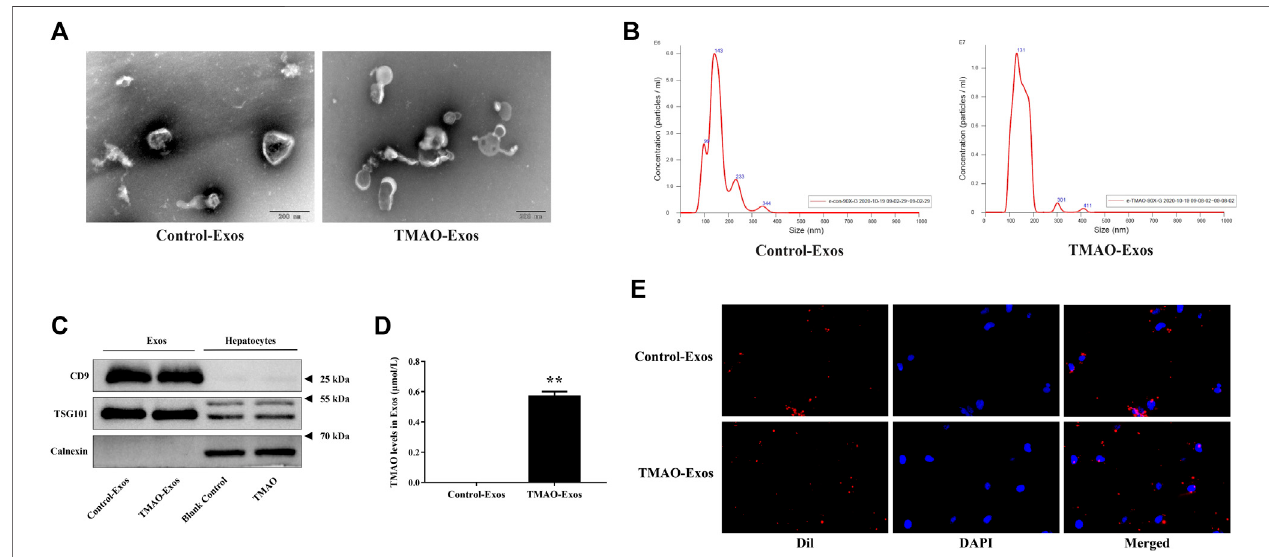
FIGURE 1 | Isolation and characterization of exosomes from hepatocyte culture supernatant. (A) Nanovesicles with diameters around 100 nm were isolated and puri fi ed from the AML12 cell culture supernatant, which possessed the characteristic size range of exosomes (Exos) under electron microscopes. Bar: 200 nm. (B) The size distribution of the Exos showed no signi fi cant difference between trimethylamine-N-oxide (TMAO)-free group (Control-Exos) and TMAO-Exos. (C) Exosomal markers of CD9 and TSG101 were enriched in Exos groups, and the negative markers of calnexin were detected only in whole cell lysate. (D) TMAO was undetectable in Control-Exos, but a small quantity of TMAO remained in TMAO-Exos. Data were expressed as mean ± standard error of the mean (SEM). n = 3, independent t -test wasperformed for comparisons; ** p < 0.01 versusControl-Exos. (E) Exosomes were labelled with DiIand co-cultured with human aortic endothelial cells (HAECs) for 24 h, and it was shown that DiI-labeled Exos could be taken up by cells (×400 magni fi cation).